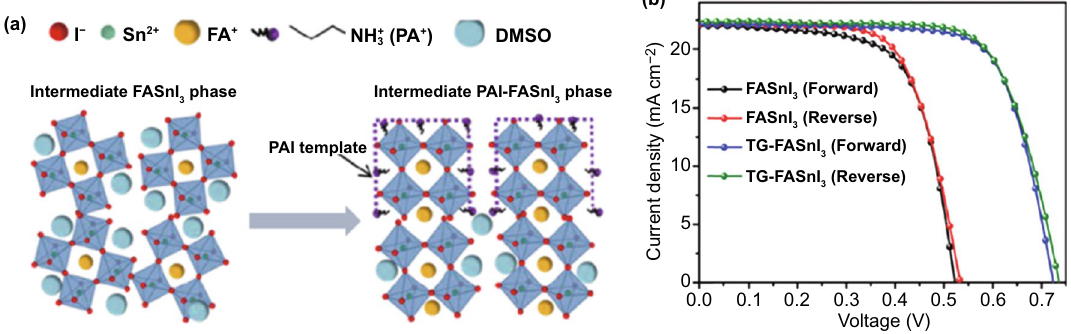
Fig. 7 a Possible mechanism of the template-growth process for FASnI 3 perovskite film. b J-V plots of the champion tin PSCs based on control and template-growth